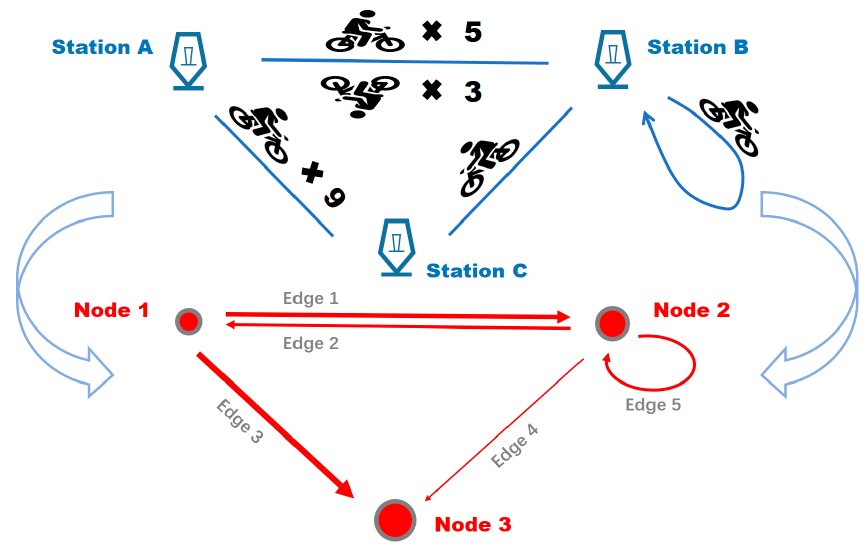
Figure 3. Network organization of riding data.